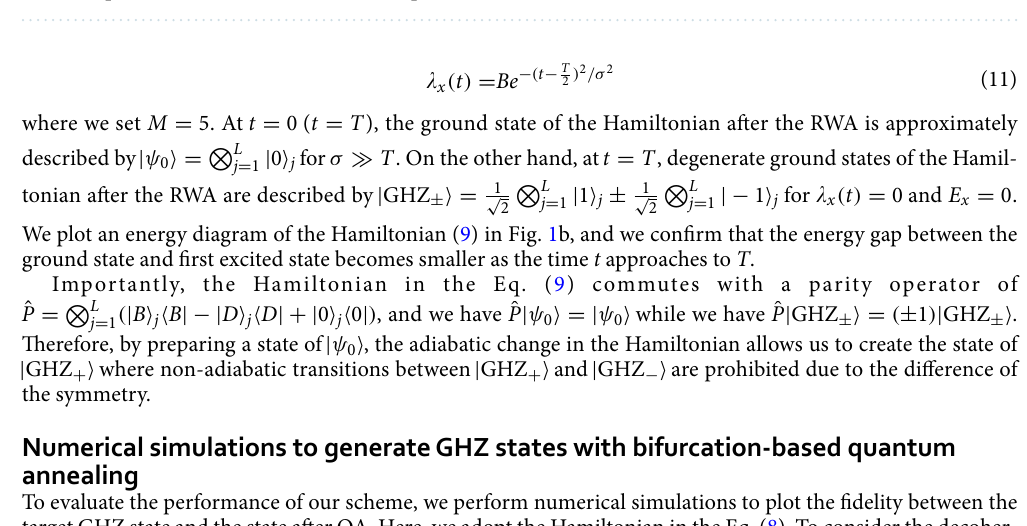
Figure 2. ( a ) We plot a fidelity against the time with the unit of milliseconds where we adopt the Hamiltonian 200 kHz, E ( 1 ) 2 π E kHz, without a rotating wave approximation. We set the parameters as L = 2, D ′ 0 / 2 π x / = = 0.2 T , T 0.1 ms, γ 1.2 , J 12 / 2 π 30 kHz, J 340 kHz, σ 0 , and 2 π 60 kHz, B / 2 π E ( 2 ) x / E ( 1 ) x ′ 12 / = = = = = = = 40 MHz. ( b ) We plot a fidelity against the time under the effect of decoherence with γ 0.5 kHz. We use ω = = the same parameters as that used in ( a ) except the decoherence